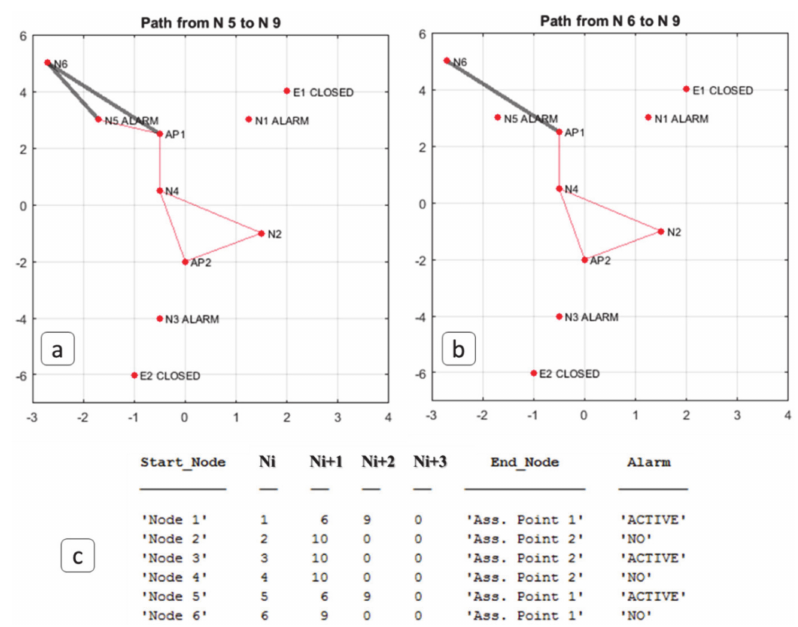
Figure 18. Example of the safest and fastest paths provided by the Algorithm 3 in case of an environmental / structural alarm at nodes 1, 3, and 5 (N1, N3, and N5), for the people at ( a ) nodes 5 (N5)